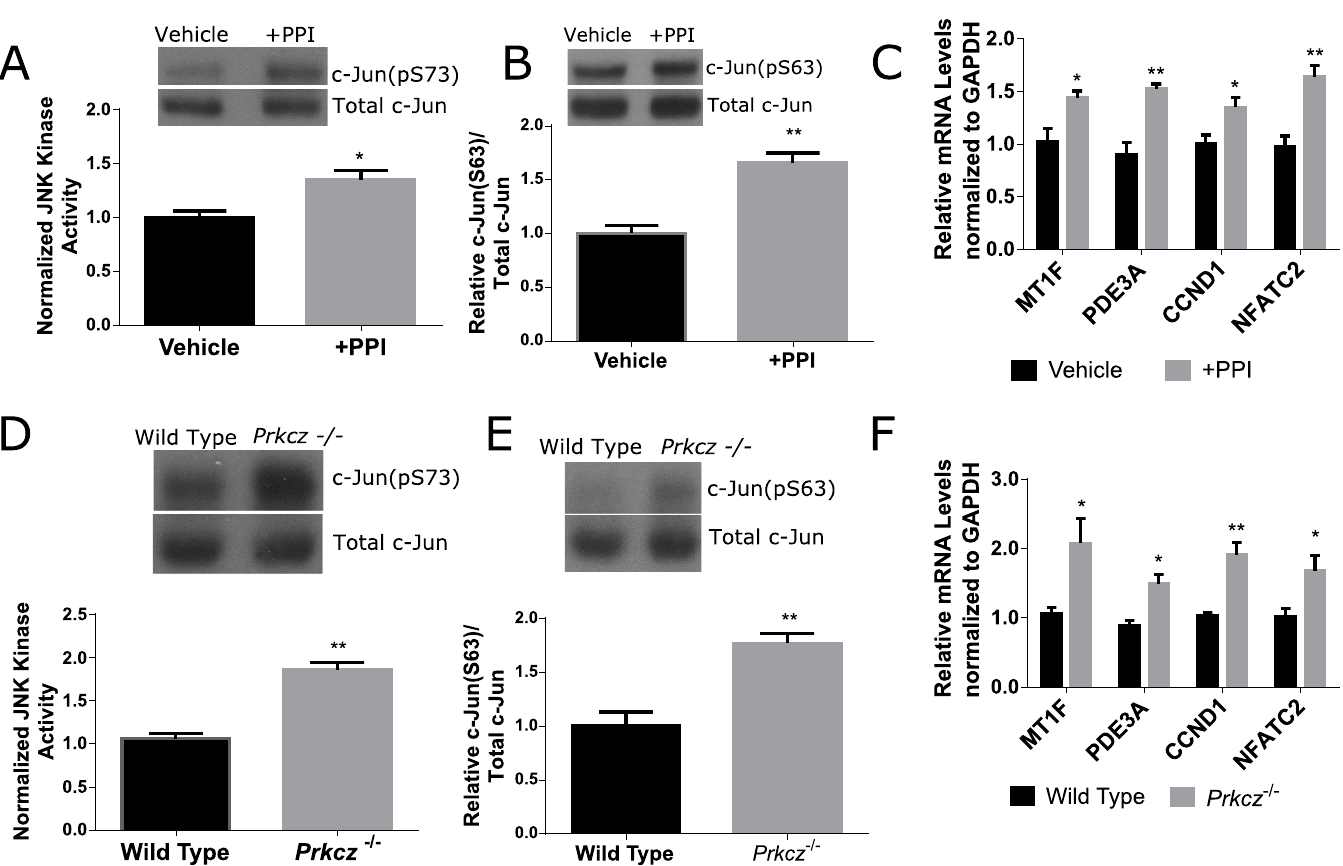
Fig 5. Modulation of PKC z increases JNK signaling. Parotid salivary glands from FVB mice were dissected and cultured as primary cell cultures. At sub-confluency, the cells were treated with 20 μ M PKC z pseudosubstrate inhibitor (PPI) or vehicle control. (A) Relative JNK kinase activity was measured by incubating immunoprecipitated JNK in the presence of ATP and c-Jun substrate in cells treated with 20 μ M PPI or vehicle control. The amount of phosphorylated c-Jun (S73) was detected via immunoblots. (B) Total protein levels for phosphorylated c-Jun (S63) was determined following PPI inhibition. Immunoblots were reprobed with total c-Jun as a loading control. Relative quantification is depicted below the blot. (C) Relative mRNA levels of MT1F, PDE3A, NFATC2, and CCND1 were determined by RT-PCR and normalized to GAPDH as a loading control. Lysates and mRNA were collected from C57BL/6J wildtype and Prkcz -/- mice. (D) Relative JNK kinase activity was measured by incubating immunoprecipitated JNK in the presence of ATP and c-Jun substrate in wildtype or Prkcz -/- mice. The amount of phosphorylated c-Jun (S73) was detected via immunoblots. (E) Total protein levels for phosphorylated c-Jun (S63) was determined in wildtype or Prkcz -/- mice. Immunoblots were reprobed with total c-Jun as a loading control. Relative quantification is depicted below the blot. (F) Relative mRNA levels of MT1F, PDE3A, NFATC2, and CCND1 were determined by RT-PCR and normalized to GAPDH as a loading control. Results are presented from at least four mice for in vivo experiments or three independent in vitro primary cell culture experiments per condition; error bars denote mean ± SEM. Significant difference (p < 0.05) was determined by Student’s t-test. � (p < 0.05), �� (p < 0.01).